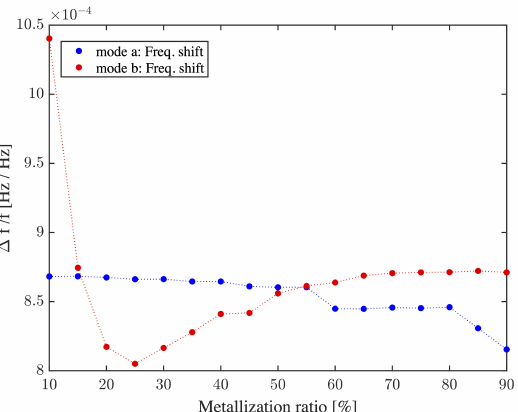
Figure 10. Sensitivity of the device depending on IDT metalization ratio in response to a 100 kg/m 3 increase in PMMA